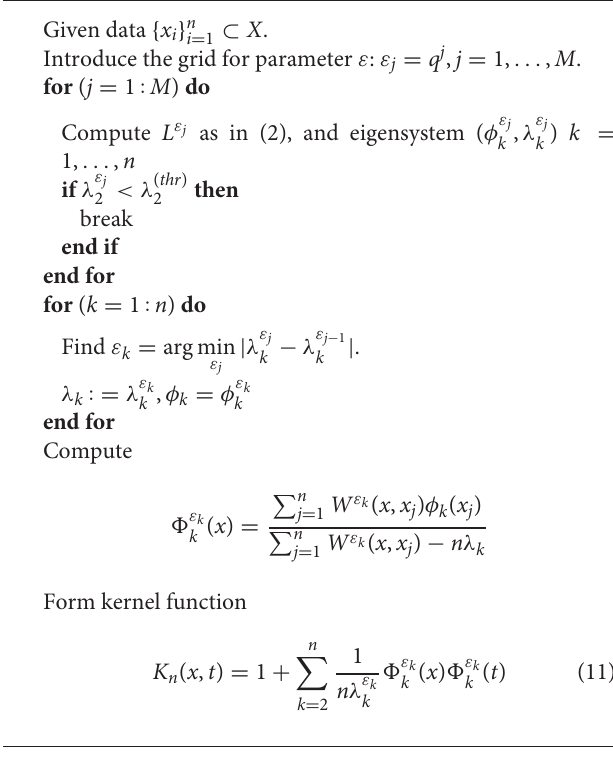
Algorithm 1: Algorithm to generate reproducing kernel from data ⊂ X . Given data { x i } n i = 1